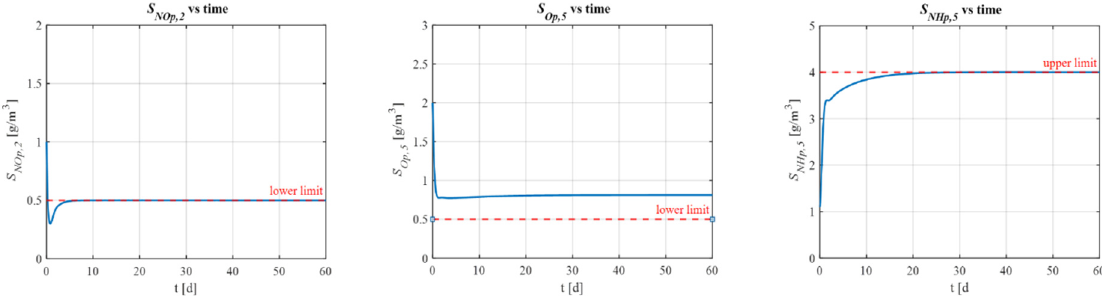
Figure 8. Fast CA results—Plant variables.